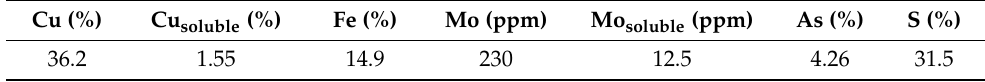
Table 1. Chemical composition of copper concentrates determined by XPS analysis.